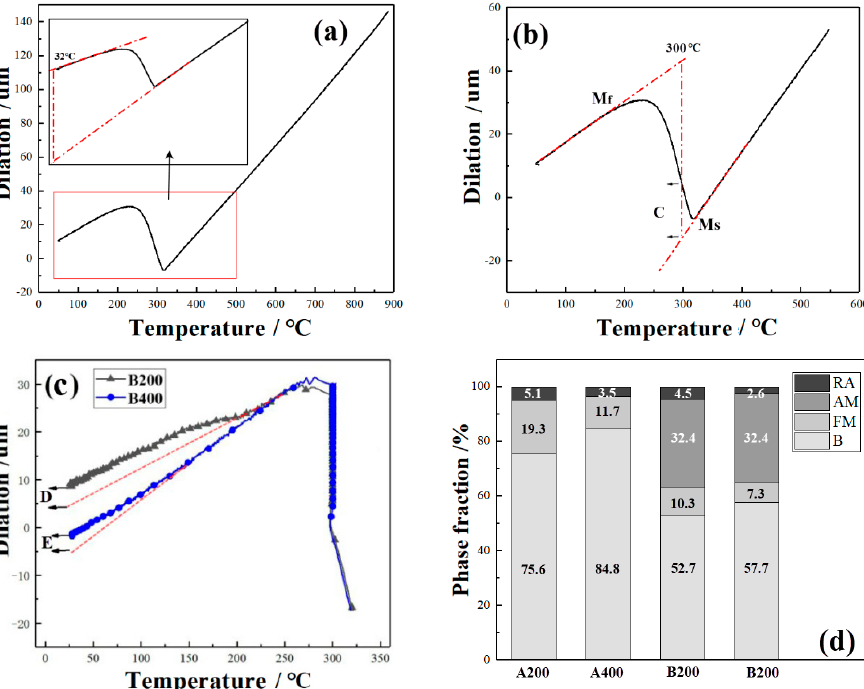
Figure 7. ( a ) The dilation curves of direct quenching sample; ( b ) the example of lever rule; ( c ) the